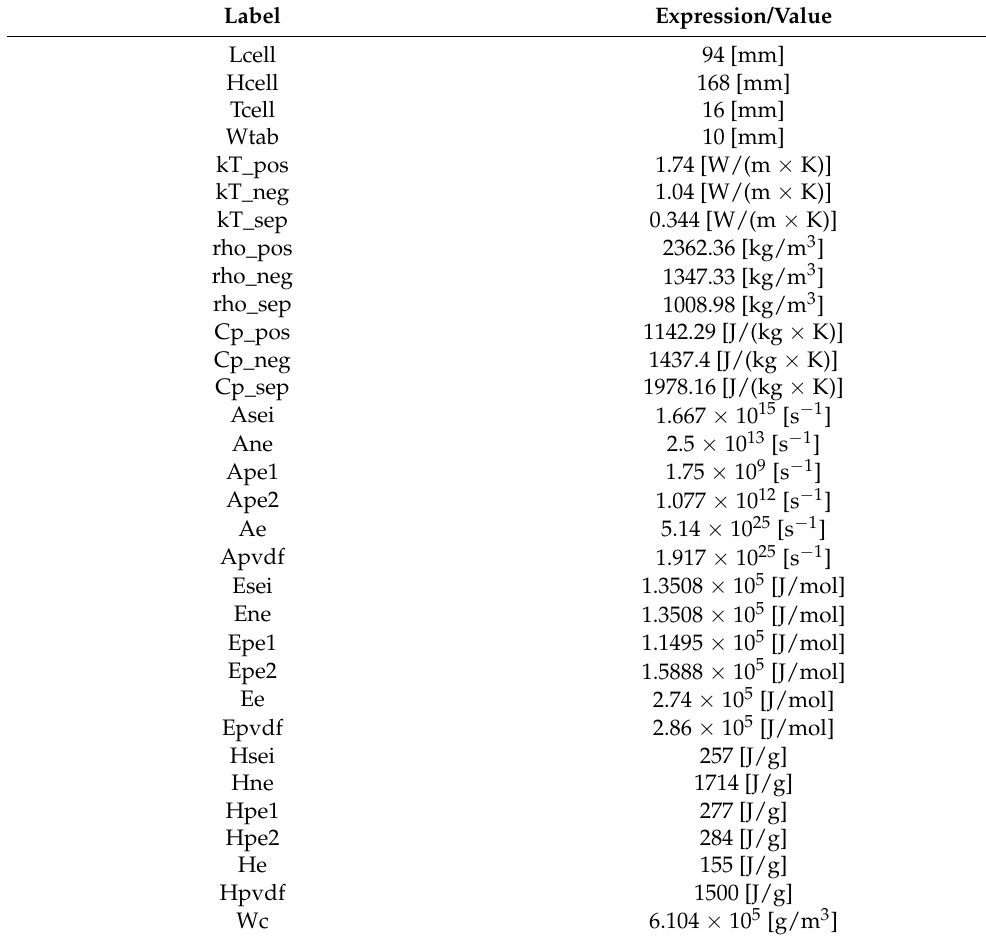
Table 4. Part of the simulation boundary